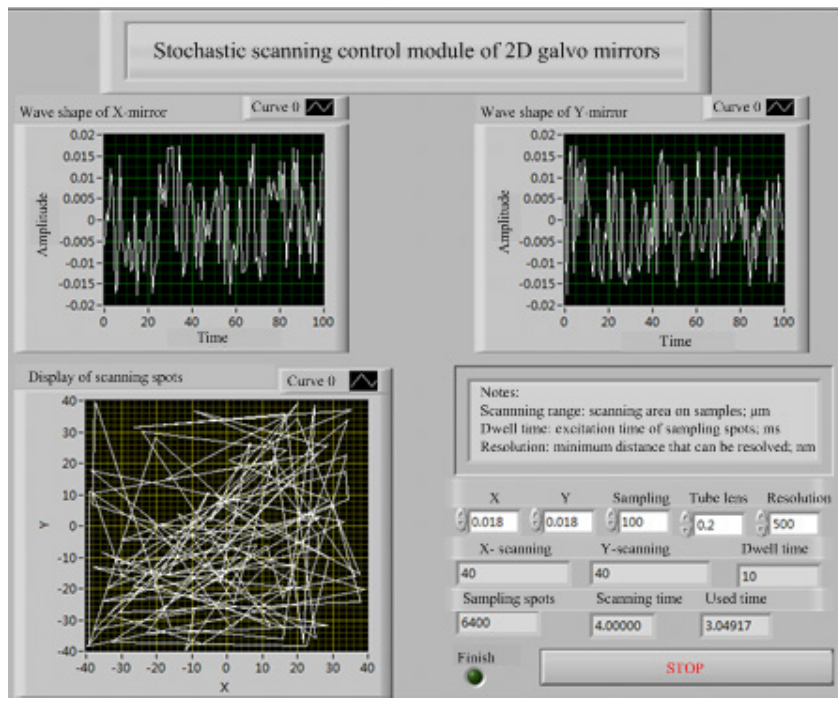
Fig. 2. Interface of scanning control module for 2D galvanometer